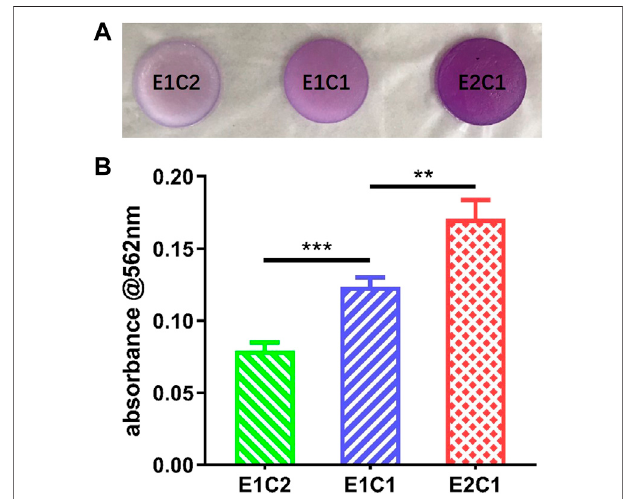
FIGURE 5 | (A) Macrophotographs of different scaffolds after BCA reaction. (B) The OD value of the BCA reaction solution at 562 nm ** p < 0.01, *** p < 0.001.